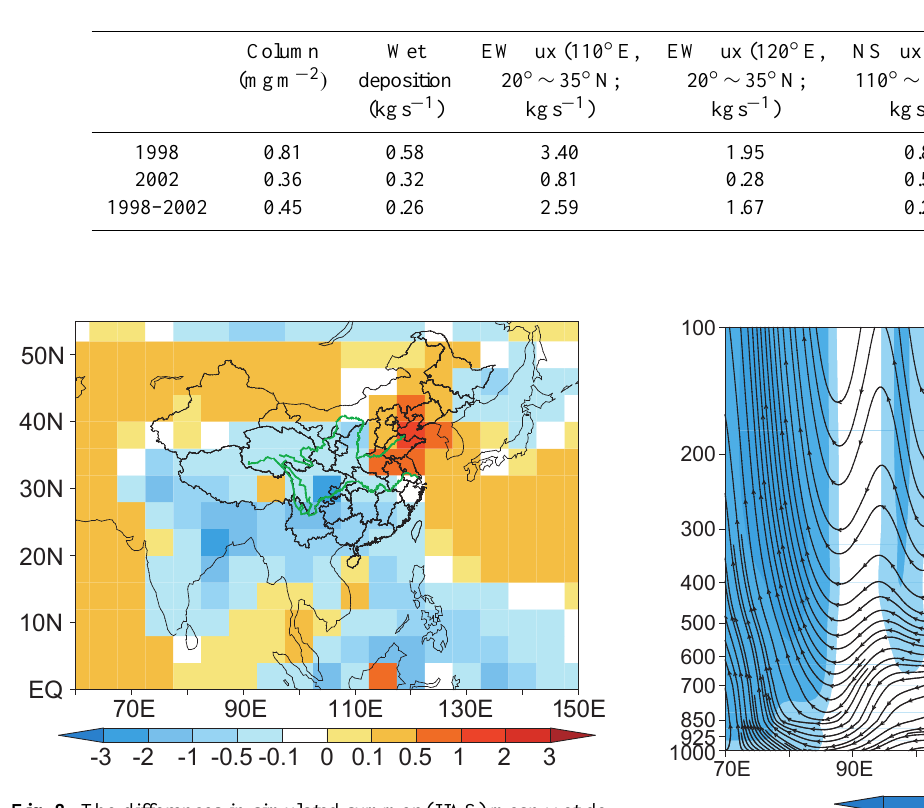
Fig. 8. The differences in simulated summer (JJAS) mean wet de- position of OC between 1998 and 2002 (the former minus latter). Unit: kgs − 1 .